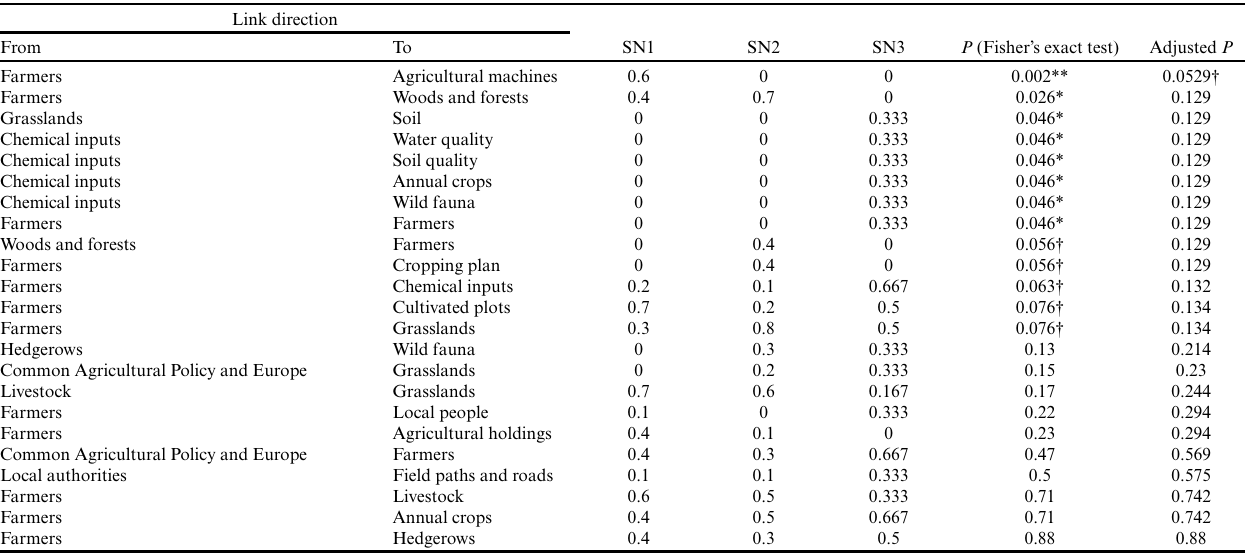
Table 7. Links tested during the comparative analysis of farmer groups based on types of semi-natural areas management practices (typology